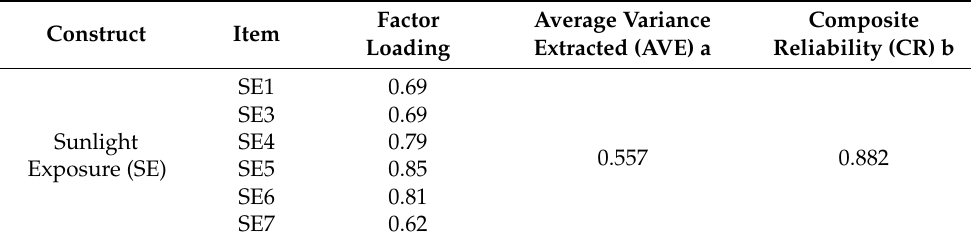
Table 5. Research Variables’ Question Item Convergence